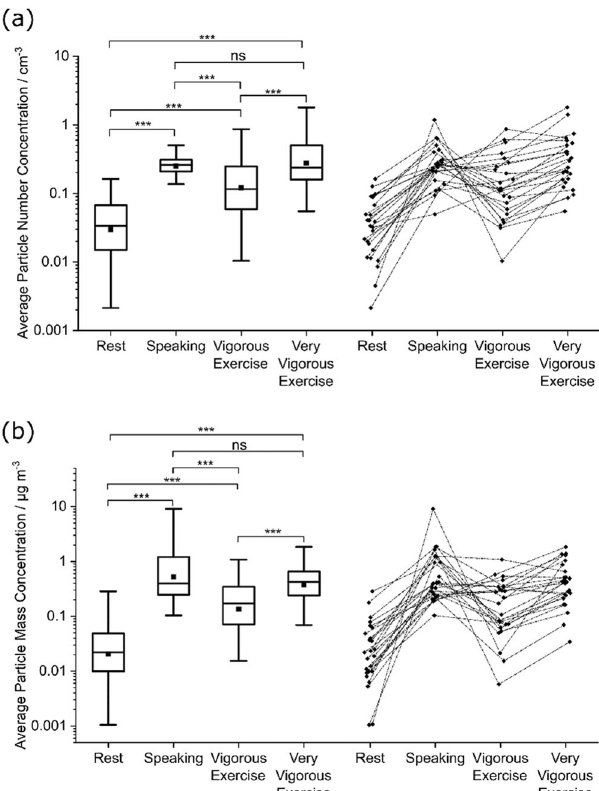
Fig. 2 Aerosol number and mass concentrations for breathing at rest and during exercise, and while speaking. Box and whisker plots (left) and corresponding data (right) showing average particle number concentrations ( a ) and mass concentrations ( b ) for the same series of activities (breathing at rest, during vigorous exercise, during very vigorous exercise, and speaking at 70 – 80 dBA) across n = 25 participants, sampled via APS-mask. Boxes indicate mean, median and IQR, whiskers indicate range (data within 1.5 IQR), *** indicates p < 0.001, not signi fi cant (ns). ns not signi fi cant, APS aerodynamic particle size, IQR interquartile